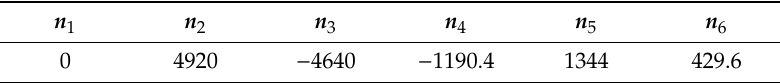
Table 2. Rotational speed of each gear shaft (rpm).